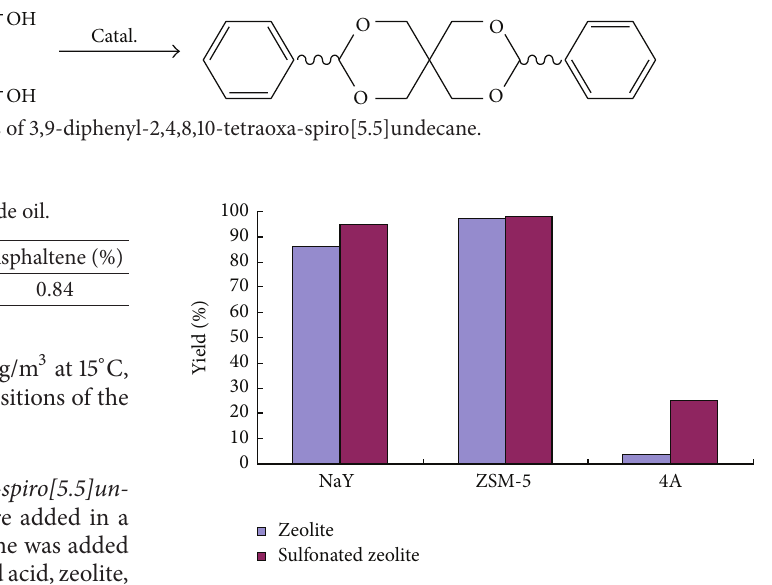
Figure 1: The yield of 3,9-diphenyl-2,4,8,10-tetraoxa-spiro[5.5]un- decane catalyzed by zeolite.